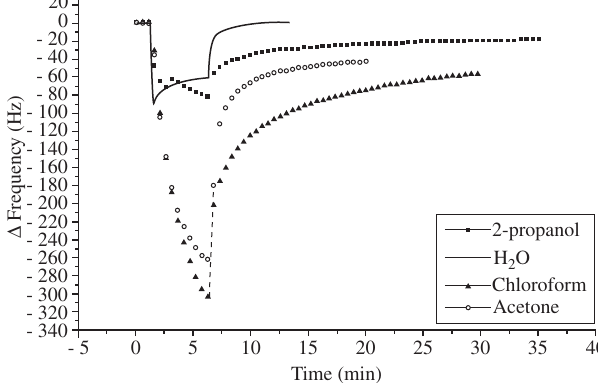
Figure 4. Crystal frequency variation vs. time for different contaminants. Acetone film deposited on